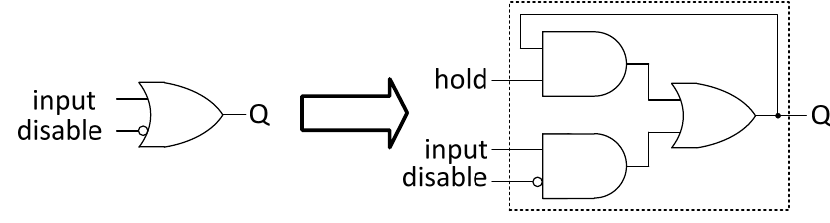
Figure 4. Modifying the OR gates to achieve self-sustaining